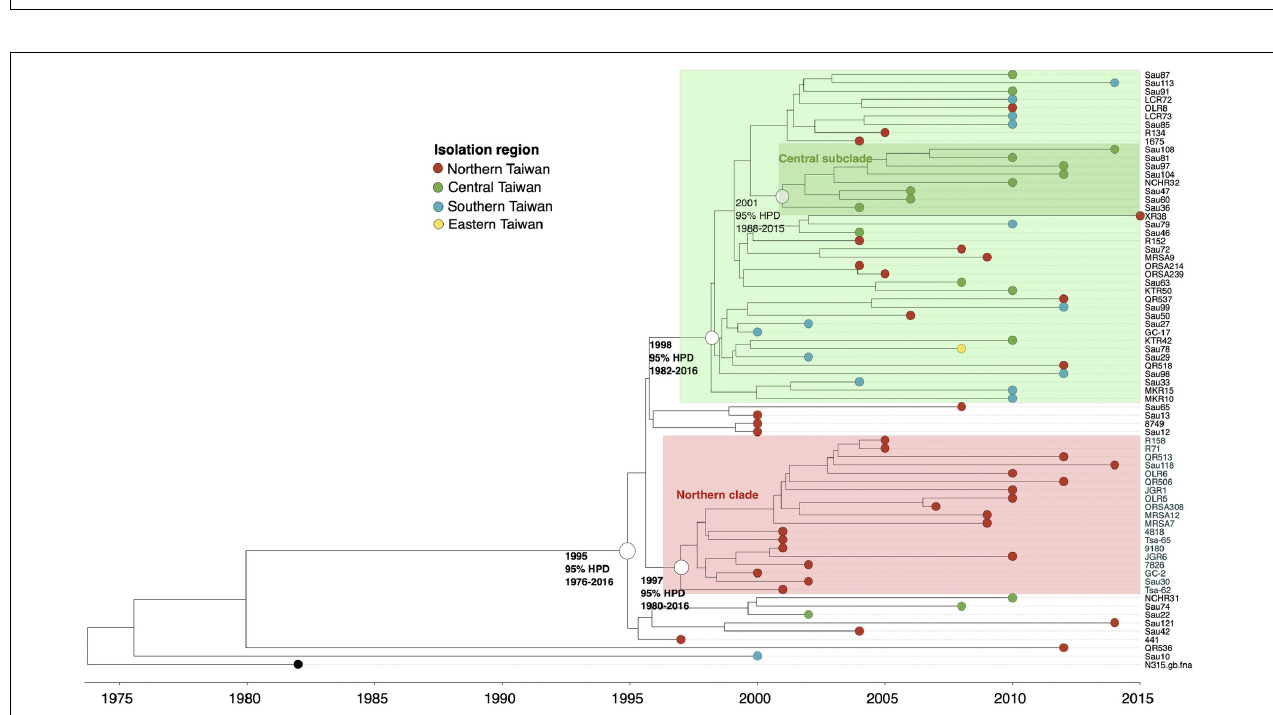
FIGURE 2 | Time-scaled phylogeny of 129 methicillin-resistant Staphylococcus aureus isolates of the ST59 lineage collected in Taiwan during 1996 and 2016. Two major clades were marked with different colors. The hollow circles indicate the most recent common ancestors of isolates of the indicated clade and its estimated year of appearance. A subclade (marked as dark blue) in clade Ia that diverged in 2005 was exclusively identified in northern Taiwan, suggesting a local transmission of the strain. HPD, highest posterior density; SLV, single-locus variants.